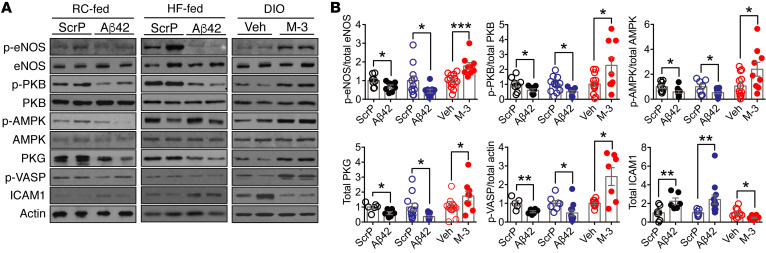
BACE1 activity and Aβ42 regulate aortic NO signaling.(A) Representative immunoblots of p-eNOS(Ser1177), eNOS, p-PKB(Ser473), PKB, p-AMPK(Thr172), AMPK, PKG, p-VASP(Ser239), ICAM1, and actin in aortas of ScrP- and Aβ42-treated RC-fed (left panel) and HF-fed (5 weeks) WT mice (middle panel) and in aortas of vehicle- or M-3–treated DIO mice (right panel). (B) Ratio of signal intensities for p-eNOS to eNOS, p-PKB to PKB, p-AMPK to AMPK; and for PKG, p-VASP, and ICAM1 to actin (n = 5–14). Data are means ± SEM. *P < 0.05; **P < 0.01; ***P < 0.001 by Mann-Whitney U test.